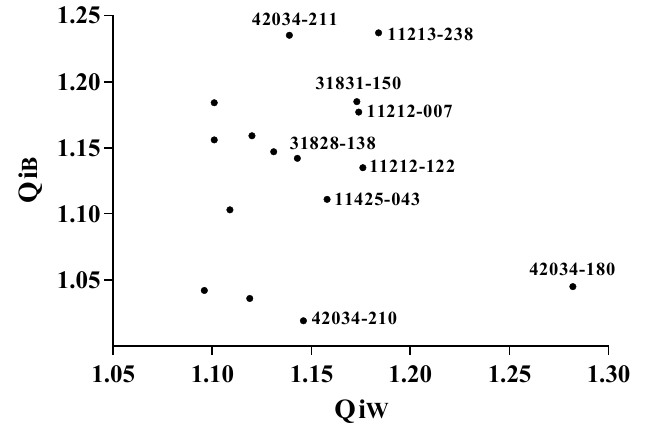
Figure 7. Q i values of 200 C. fargesii clones based on wood traits by comprehensive evaluation methods. Q iB , Comprehensive evaluation of the breeding values of the Pilodyn value and MOE; Q iW , comprehensive evaluation of the Pilodyn value and MOE.